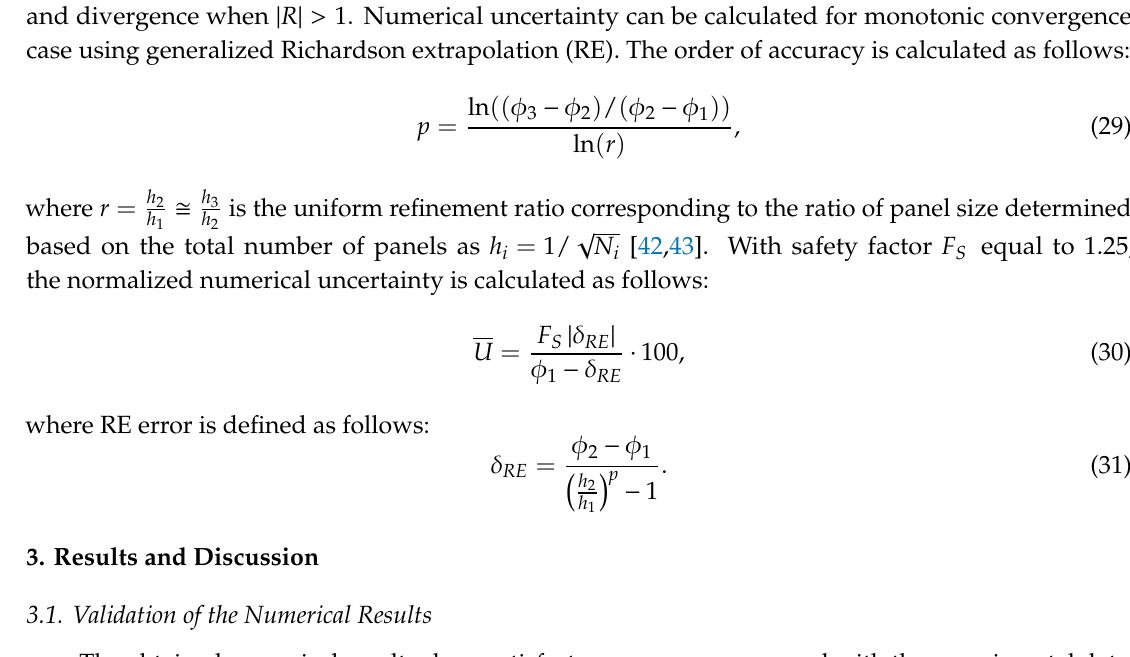
Figure 5. Comparison of the numerically obtained heave (left) and pitch (right) transfer functions with available experimental data [36–38]. 3.2. Verification of the Numerical Results Table 2 shows the hydrostatic characteristics of KCS obtained using panel models with different mesh density. The differences between the hydrostatic characteristics for different panel models are not significant, even though the displacement volume of the finest discretization is closest to the actual value. It should be noted that the position of the vertical centre of buoyancy is given with the respect to the coordinate system located on the mean free surface. The effect of panel model discretization on the obtained results of heave and pitch motion amplitudes can be seen in Figure 6. Increasing the number of panels does not influence the obtained results, unlike in the case of added resistance. The largest change in the results is obtained for the highest frequency using fine mesh. Without the correction being applied, this value has the lowest relative deviation compared with the experimental results. The numerical uncertainty of the obtained added resistance coefficient in regular waves and coefficient of the mean added resistance in irregular waves can be seen in Table 3. It can be seen that the calculated numerical uncertainty, for the results with monotonic convergence, is below 2.1% for regular and equal to 1.64% for irregular waves. Table 2. Hydrostatic characteristics of KCS obtained using different panel models. i N